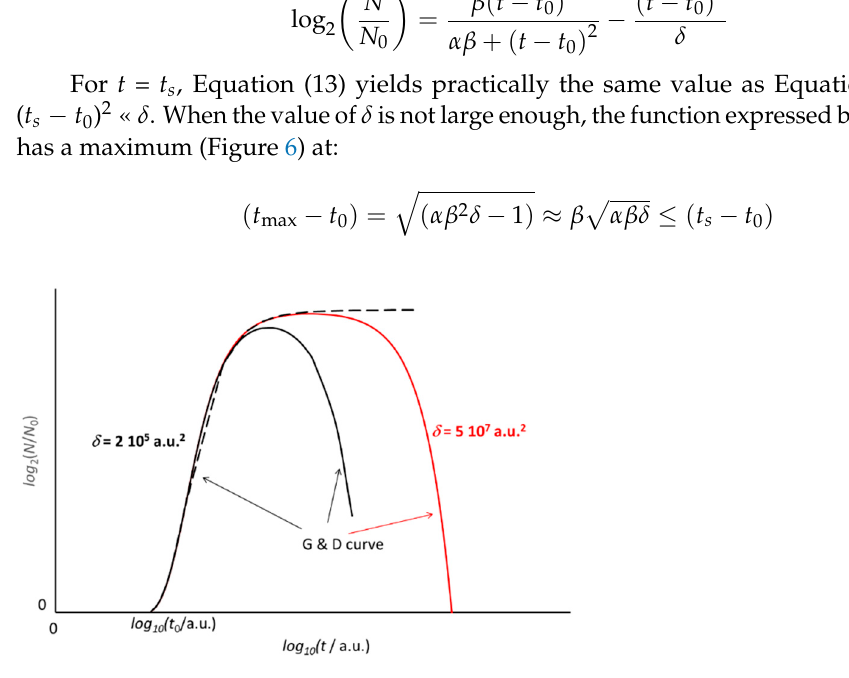
Figure 6. A single function describes the whole growth and decay (G and D) evolution of the microbial culture. Trends according to Equation (6) with different values of the parameter δ . When the decay pace is quick (small δ , black line), a broad maximum of the G and D trend replaces the pseudo steady phase (large δ , red line). In any case, the early rising trend of the growth (dotted line) does not change. For the sake of comparison, the abscissa is in log 10 scale.